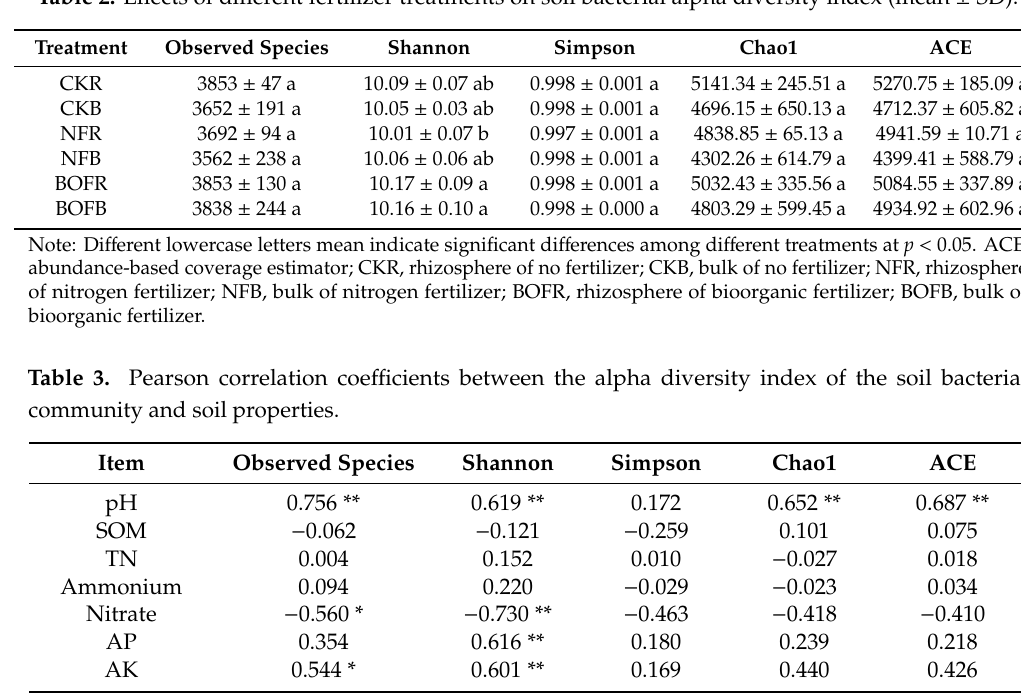
Table 2. Effects of different fertilizer treatments on soil bacterial alpha diversity index (mean ± SD). Treat-